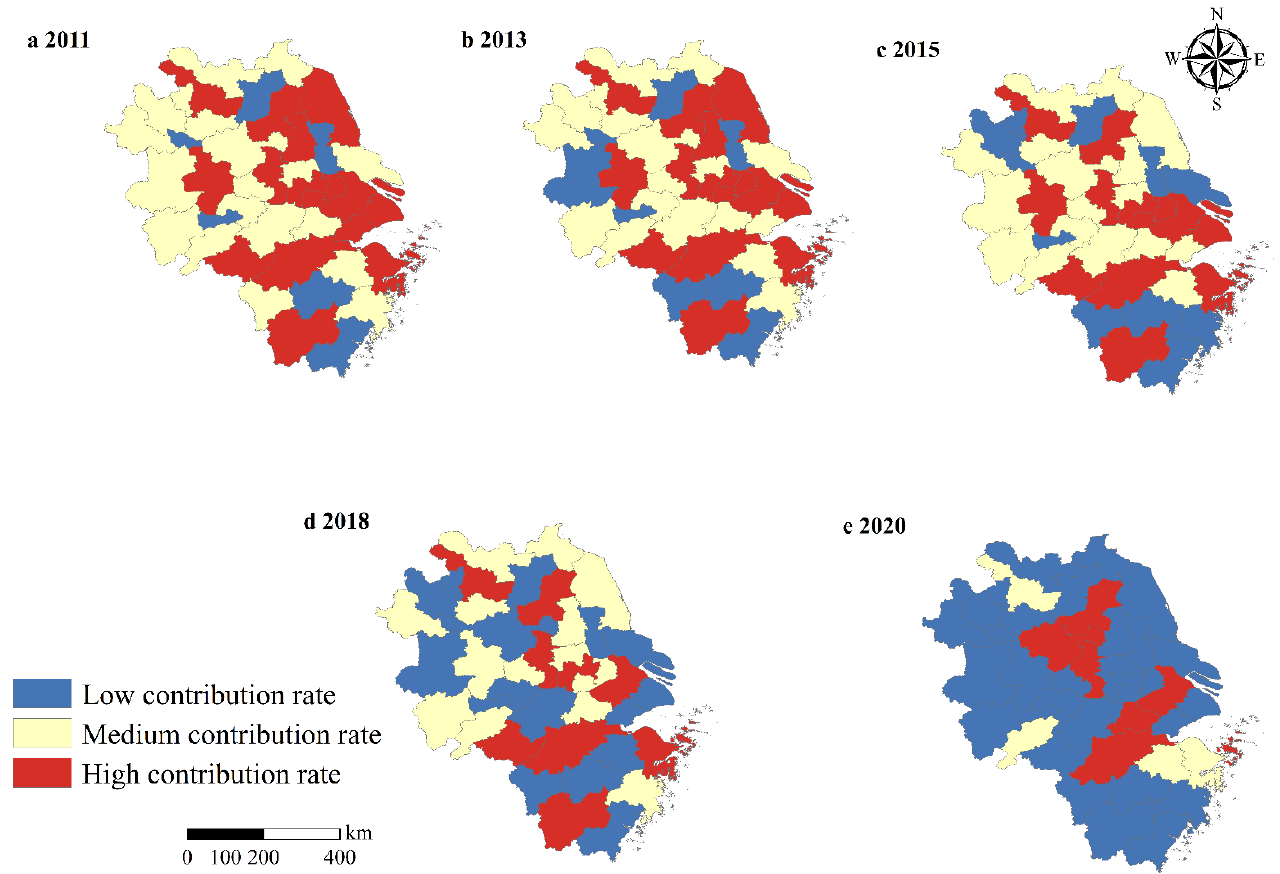
Figure 3. Spatio-temporal patterns of contribution rate of GASTP in 2011, 2013, 2015, 2018, and 2020.